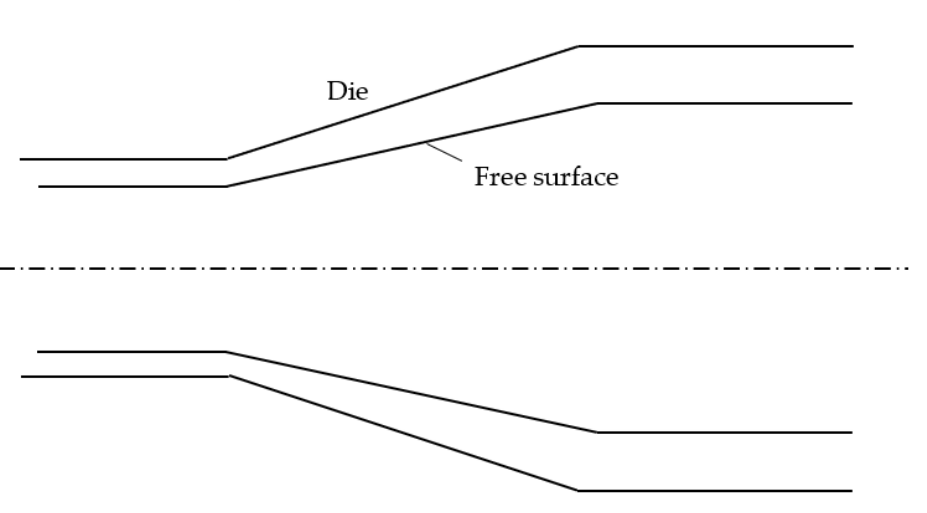
Figure 2. Schematic diagram of a tube sinking process.